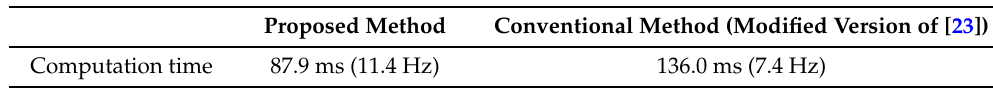
Figure 14. Obstacle segmentation results for nonobstacle images when the floor appearance changes. Table 3. Computation time